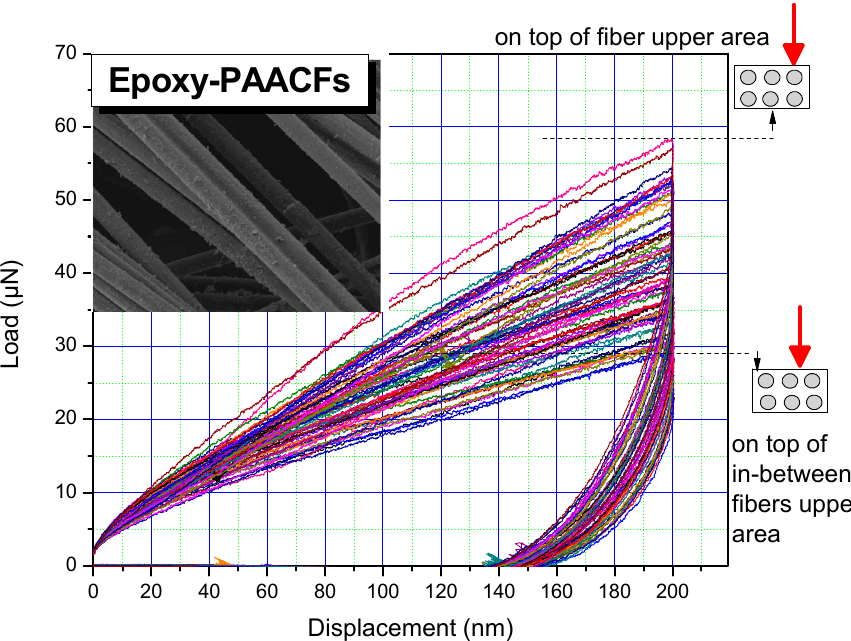
Figure 4. Load ‐ displacement data from the loading ‐ unloading mapping measurements at 200 nm of displacement, for the epoxy ‐ PAACFs sample.